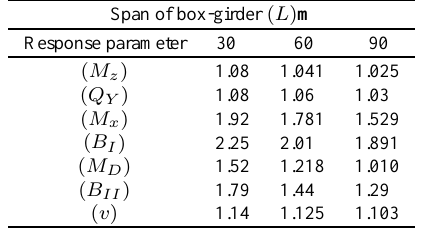
Table 7 Effect of span of box-girder bridge on impact factor